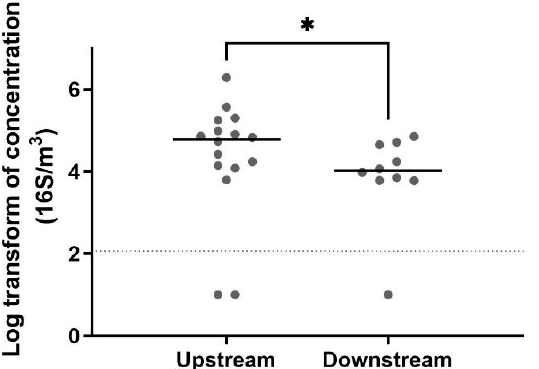
Figure 2. Biomass concentration for air samples collected upstream ( n = 16) and downstream ( n = 10) of the biofilter (*: 0.01 < p -value < 0.05). The horizontal line represents the median value. The dots represent the value concentration for each sample. A reduction of 88% was observed between the mean concentration measured in air samples collected upstream and downstream.